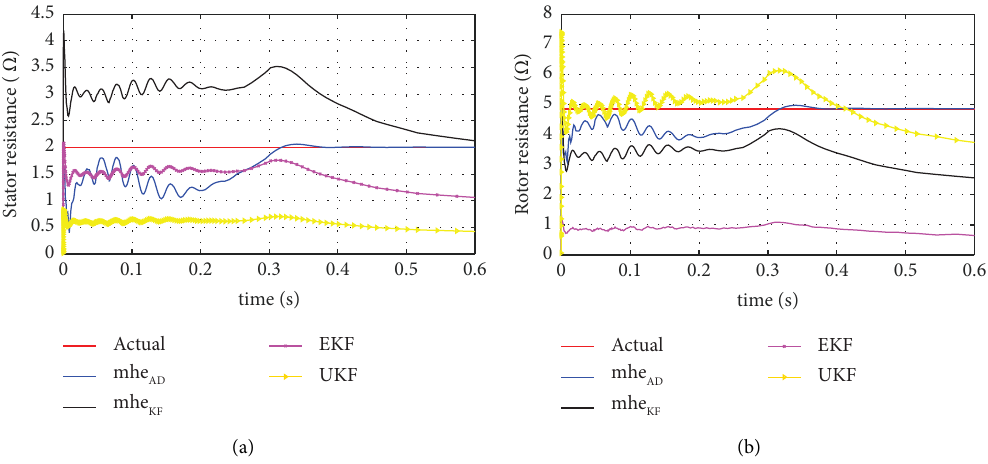
Figure 4: (a) Estimation of stator resistance. (b) Estimation of rotor resistance.